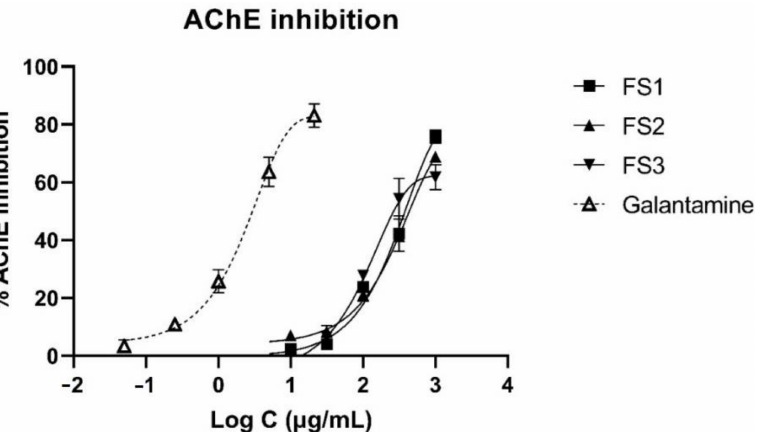
Figure 2. Achetylcholinesterase (AChE) inhibition by F. schleicheri extracts and galantamine as reference